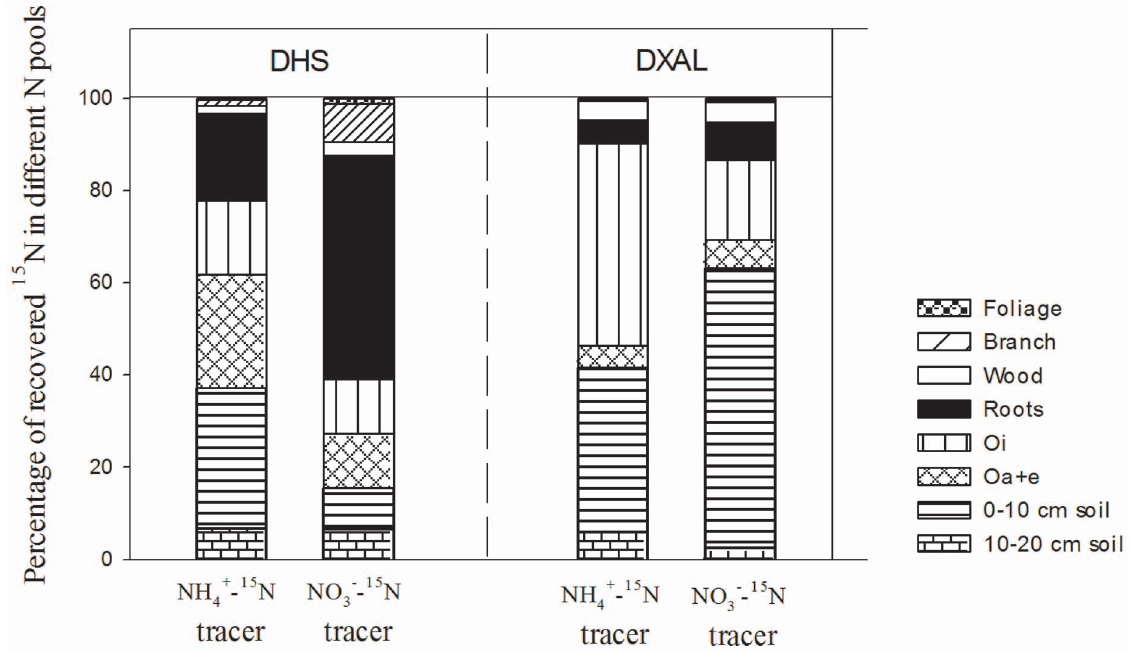
Figure 2. Percentage of recovered 15 N in different ecosystem N pools in the subtropical forest ecosystem at DHS and in the boreal forest ecosystem at DXAL in the ( 15 NH4) 2 SO 4 and K 15 NO 3 application